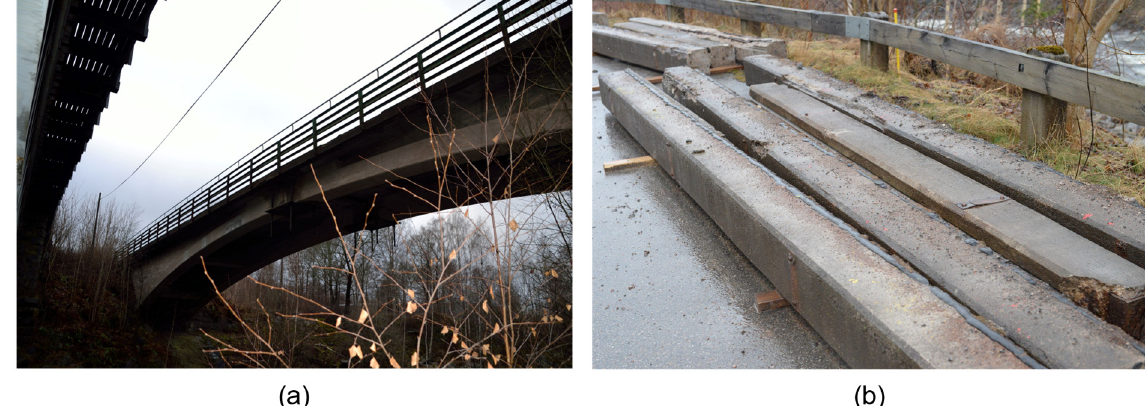
Figure 1. Overview of Gullspång bridge (a) and extracted edge beams (b). Table 1. Chloride and sulphate contents in recycled concrete